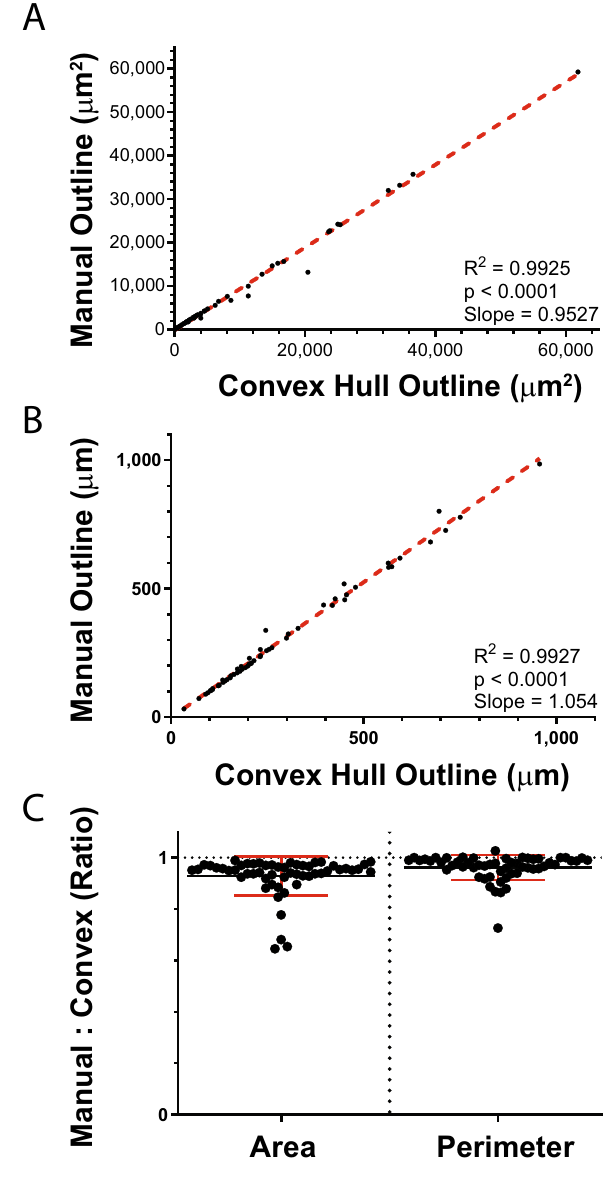
Figure 4. Convex hull representations of two-dimensional islet cross sections accurately model non-infiltrated islets. Islet images from 11-week-old NOD.RAG1.KO mice (n = 3) were obtained and islets (n = 55) were manually contoured by a blinded analyzer or overlaid with convex hulls derived from added insulin/glucagon signals using the macro methodology. Areas and perimeters of the cross-sectional polygons from both approaches were compared to validate the convex hull approach. ( A , B ) Linear regressions between ( A ) areas and ( B ) perimeters of the associated manual or convex hull outlines. ( C ) Area ratio of manual outline to convex hull outline and perimeter ratio of convex hull outline to manual outline. Dotted red lines on linear regression plots represent the line of best fit. Data are pooled from three independent